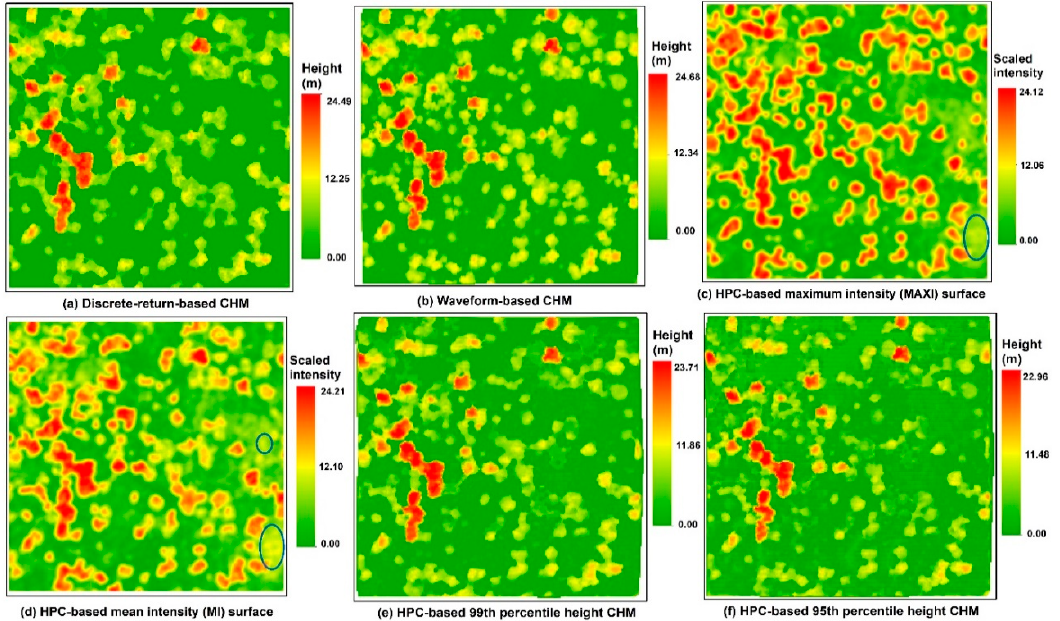
Figure 7. Comparisons of the ( a ) DR-based CHM, ( b ) waveform-based CHM, ( c ) HPC-based maximum intensity (MAXI) surface, ( d ) HPC-based mean intensity (MAXI) surface, ( e ) HPC-based 99th PH CHM, and ( f ) HPC-based 95th PH CHM over a subset region.